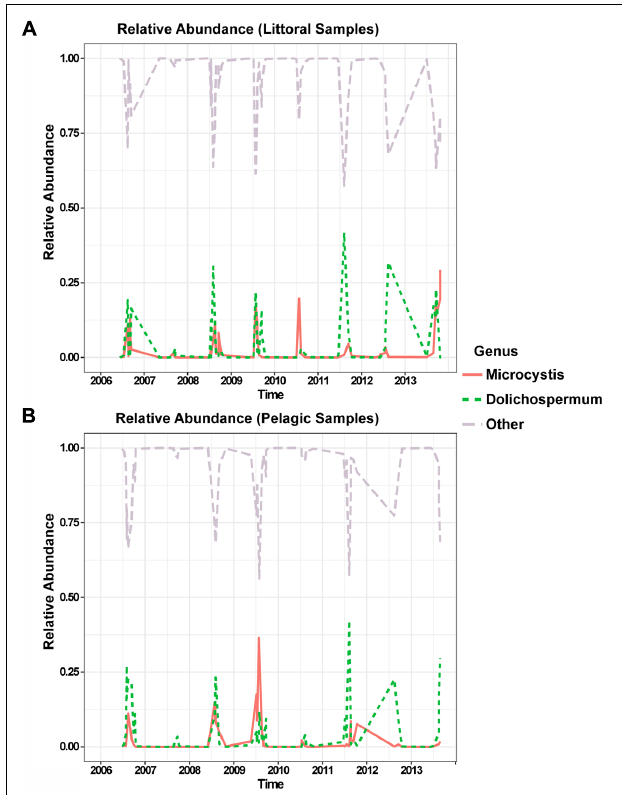
FIGURE 1 | Temporal dynamics of the two dominant cyanobacterial genera over an 8-year time-course in littoral (A) and pelagic (B) sampling sites. Relative abundance of Microcystis is shown in solid red, Dolichospermum in dashed green and the other members of the bacterial community in dashed light violet. The time scale ( x -axis) is in units of years.